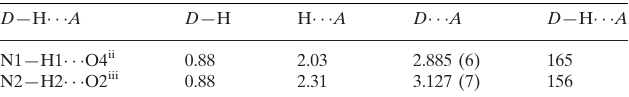
Hydrogen-bond geometry (A˚ , (cid:2)